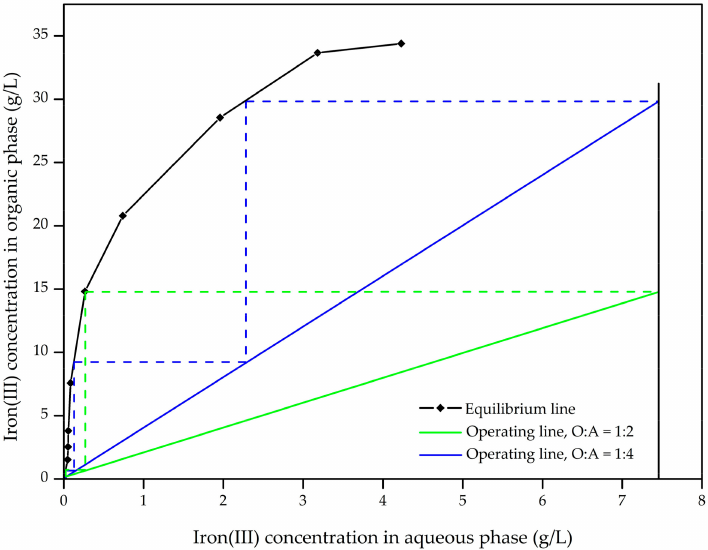
Figure 8. McCabe–Thiele plot for iron(III) extraction at different O:A ratios at C(Fe) = 7.47 g/L, C(HCl) = 6